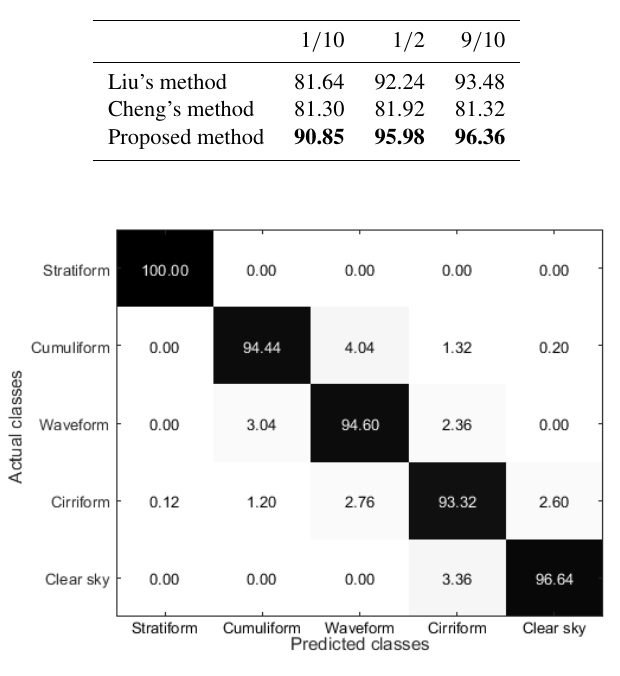
Figure 7. Confusion matrix (%) on the zenithal dataset. (1 / 2 for training and the overall accuracy is 95.98%.)